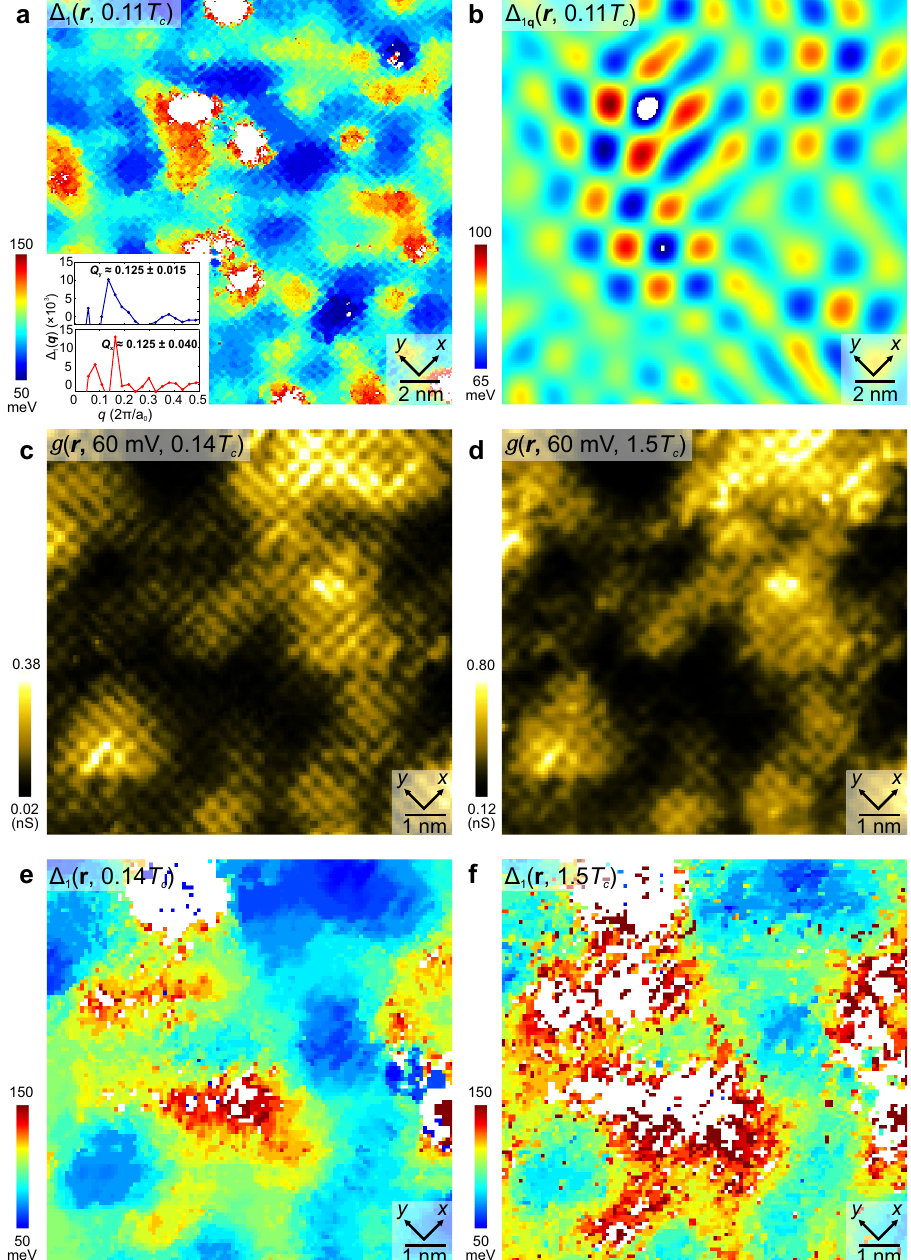
Fig. 3 Energy-gap Modulations from Superconductive to Pseudogap Phase. a Measured Δ 1 r ð Þ within 20nm×20nm FOV at T = 0 : 11 T c = 4.2K. The energy-gap is measured from the energy of the coherence peak at E > 0. The inset shows the linecuts from q = (0, 0) to (0.5, 0)2 π / a 0 and from q = (0, 0) to (0, 0.5)2 π / a 0 in the measured Δ 1 q ð Þ . The signi fi cant disorder as q → 0 in is fi tted to a cylindrical gaussian and subtracted. q (cid:2) ½ð ± 1 = 8 ; 0 Þ ; ð 0 ; ± 1 = 8 Þ(cid:7) 2 π = a 0 peaks are present in both directions. The white areas represent regions where it is impossible to determine the coherence peak position Δ 1 . b Gap modulations Δ r ð Þ from 3( a ). These are visualized at wavevectors q (cid:2) ½ð ± 1 = 8 ; 0 Þ ; ð 0 ; ± 1 = 8 Þ(cid:7) 2 π = a fi ltering Δ r ð Þ at the 1/8 peaks as shown in inset of 3a. The 1 q 0 by Fourier 1 Gaussian fi lter size σ q = 1.45 pixels (or equivalently 0.455 nm − 1 ) in q -space, which corresponds to 2.2 nm in r -space. c Measured g r ; 60 mV ð Þ at T = 0.14 T c = 5 K within 9.9nm×9.9nm FOV. The g r ; 60 mV ð Þ manifests unidirectional charge modulations. d Measured g r ; 60 mV ð Þ at T = 1.5 T c = 55 K in the identical FOV as ( c ). No change has been detected in g r ; 60 mV ð Þ at T = 55 K. e Measured Δ 1 r ð Þ at T = 0.14 T c = 5 K shows the spatial variation of the coherence peak at E > 0. f Measured Δ 1 r ð Þ at T = 1.5 T c = 55 K in the identical FOV as ( c ), ( d ) and ( e ). The spatial variation of the coherence peak is highly similar to ( e